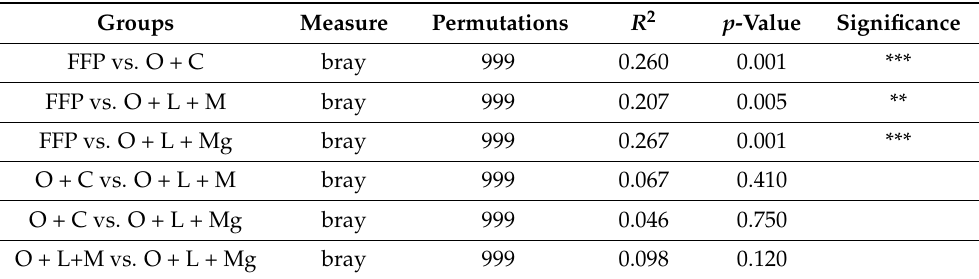
Figure 4. Changes in soil fungal community composition. Principal coordinate analysis (PCoA) showing the differences in fungal communities among different treatments and PERMANOVA (permutational analysis of variance) showing the significant differences among fungal communities of different treatments. Table 2. Significance test of differences among fungal communities under different treatments using permutational anal- ysis of variance based on Bray–Curtis distance.